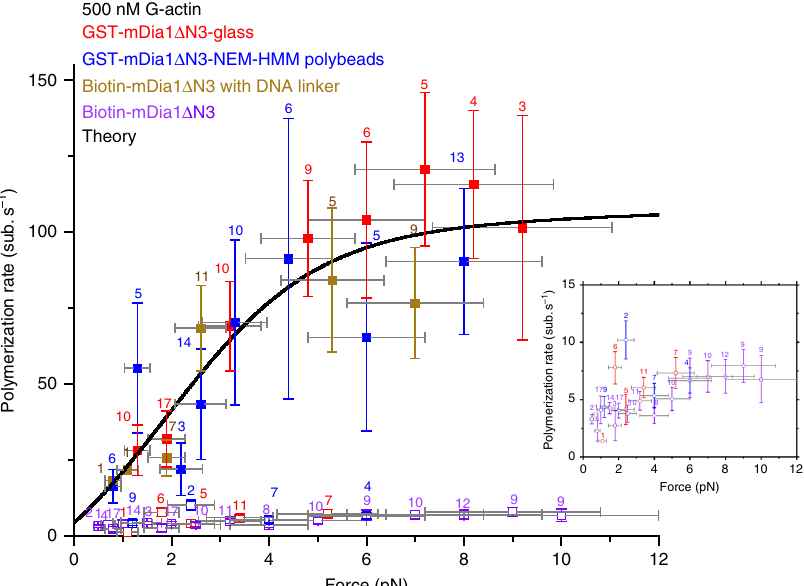
Fig. 4 Force-dependent F-actin elongation rate varies depending on tether con fi guration. The data show the actin elongation speed as a function of force for cases where GST-mDia1 Δ N3 was attached to coverslip surface (red solid and hollow squares represent the fast and slow elongating species, respectively), or to the superparamagnetic bead surface (blue), or when biotin-mDia1 Δ N3 was directly attached to streptavidin-coated superparamagnetic bead surface (purple) or to an anti-DIG coated superparamagnetic bead surface through a torsionally unconstrained DNA linker (brown). Vertical error bars represent standard errors of mean (s.e.m) obtained from multiple data points obtained at the force. Horizontal error bars represent the 20% uncertainty in force calibration. The value labeled on each data point indicates the number of independent experiments carried out at the corresponding force. Inset shows the zoom-in of the slow elongating species. All of the data were collected in the presence of 500 nM G-actin. The solid black line is the predicted ð 0 Þ (cid:5) 0 : 20 nM − 1 s − 1 when c (cid:2) 0 polymerization rate based on Eq. (1) with best fi tting parameters Δ ≈ 5.36 nm, ϵ ≈ 1.21 k B T and k (cid:2) (cid:4) is set as 400 nM. Several a sample movies of superparamagnetic beads on elongating actin fi laments are provided in Supplementary Movies 1 – 3. The elongation trajectory of an actin fi lament at two different forces corresponding to Supplementary Movies 1 – 3 are provided in Supplementary Figs. 5 – The equation contains four model parameters: c (cid:2) 0 (cid:4) , Δ , ϵ , and ð 0 Þ . The critical concentration has been reported to be ~100 nM k (cid:2) a for the barbed end of naked actin fi lament 27 and ~400 nM for mDia1 associated actin fi lament 28 . Therefore, c (cid:2) 0 (cid:4) should be somewhere between the two values. When c (cid:2) 0 (cid:4) is set as 400 nM, v ( F , c )/ δ is able to reasonably fi t the averaged speeds of fast elongating fi laments obtained from both GST-mDia1 Δ N3 and biotin-mDia1 Δ N3 with DNA linker at different forces (black solid line in Fig. 4), with the best fi tting values for the remaining ð 0 Þ (cid:5) 0 : 20 three parameters: Δ ≈ 5.36 nm, ϵ ≈ 1.21 k B T and k (cid:2) a − 1 − 1 s . When c (cid:2) 0 (cid:4) is set as 100 nM, the best fi tting parameters nM ð 0 Þ (cid:5) 0 : 23 nM − 1 s − 1 . become Δ ≈ 5.49 nm, ϵ ≈ 1.8 k B T and k (cid:2) a